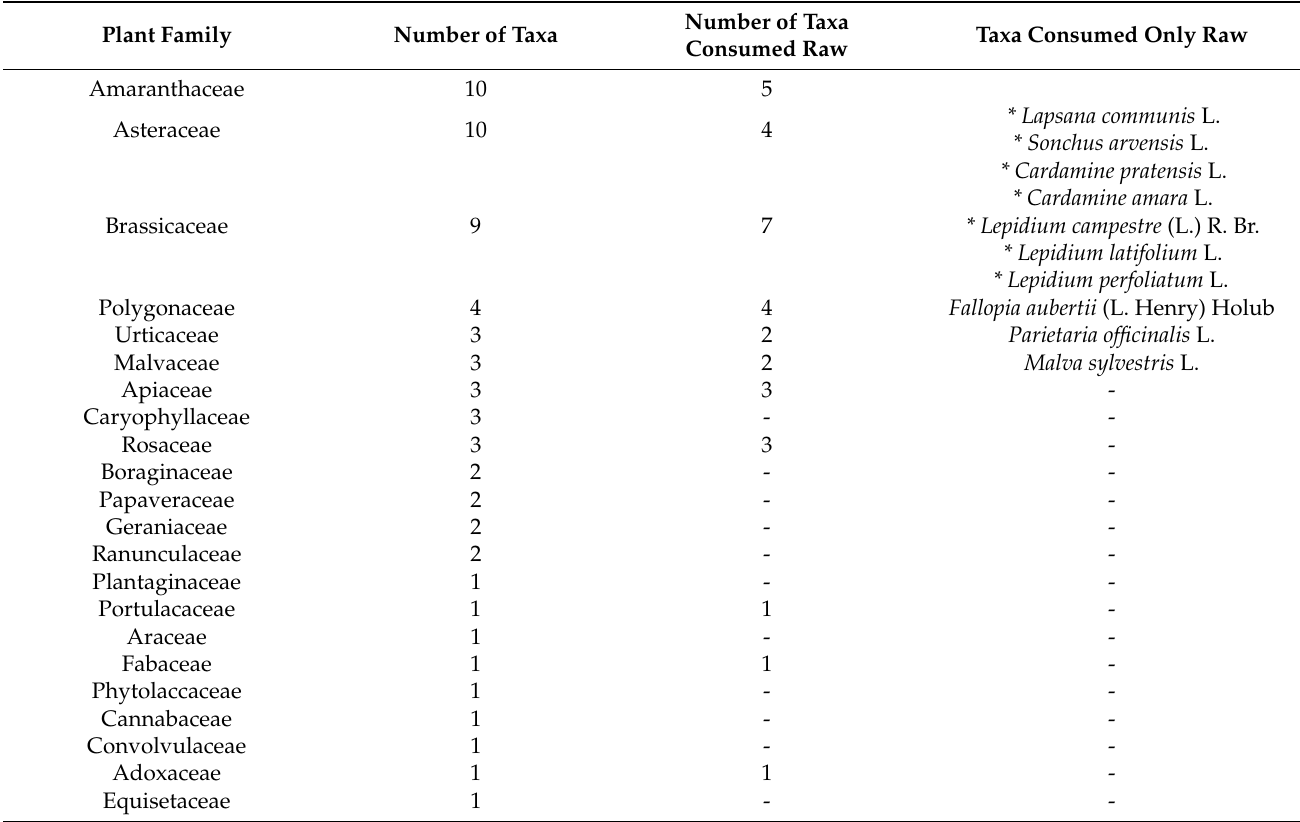
Table 1. Number of ruderal taxa consumed as spring food in Bulgaria per plant